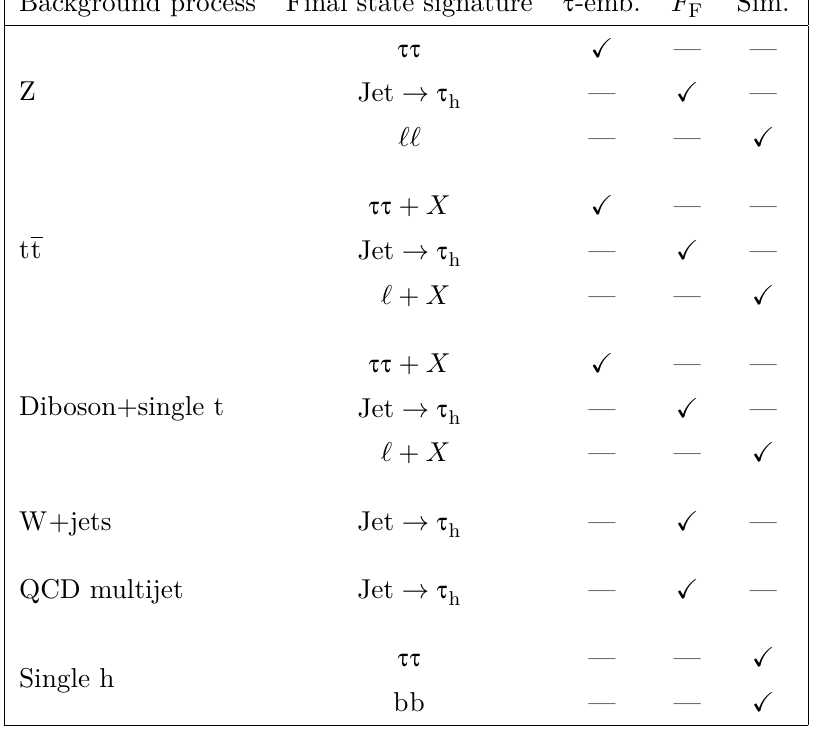
Table 1 . Background processes contributing to the event selection, as given in section 5. The symbol ‘ corresponds to an electron or muon. The second column refers to the experimental signature in the analysis, the last three columns indicate the estimation methods used to model each corresponding signature, as described in sections